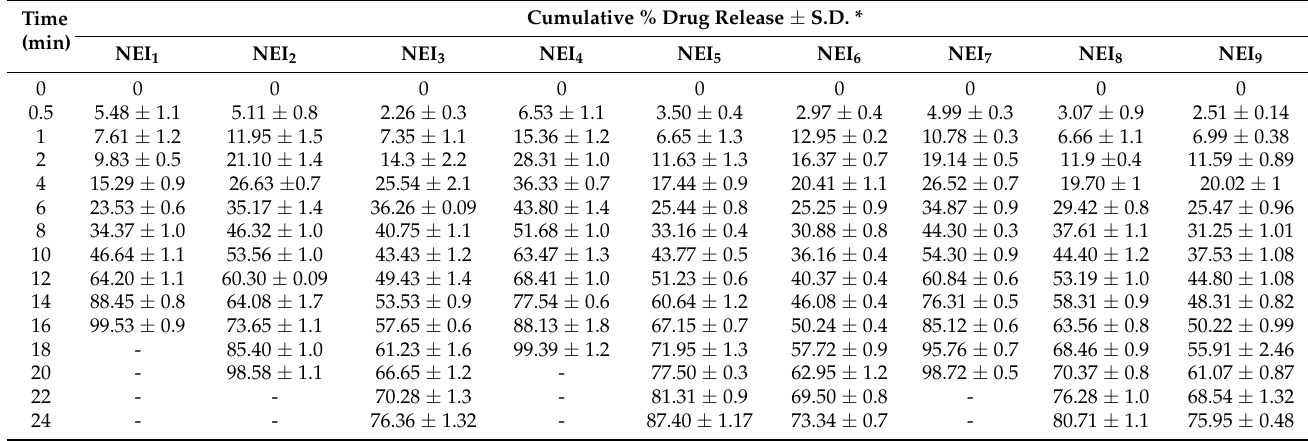
Table 5. Diffusion profiles of formulations trial batch: NEI 1 –NEI 9 .